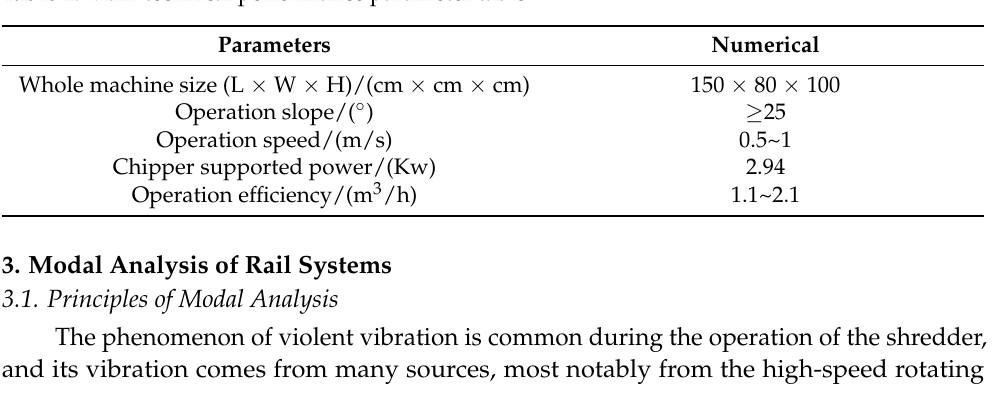
Table 1. Main technical performance parameter